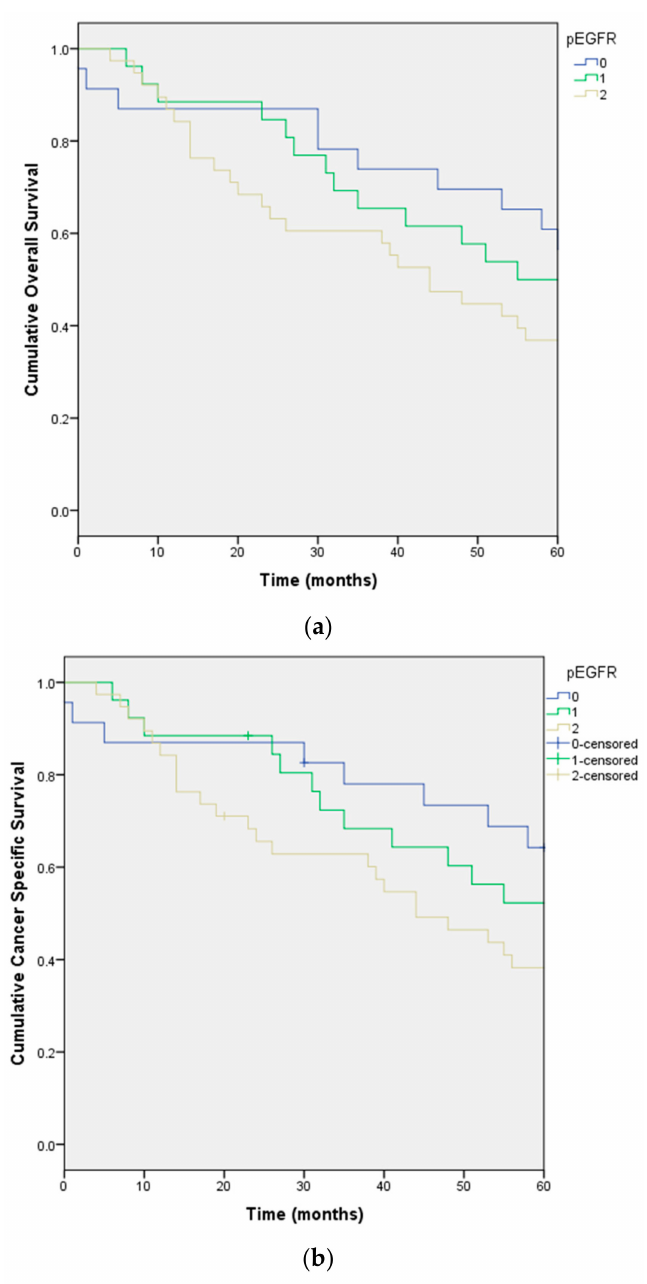
Figure 3. Overall survival ( a ); and cancer specific survival ( b ) stratified by differential expression of pEGFR in the cohort of 87 patients with soft tissue